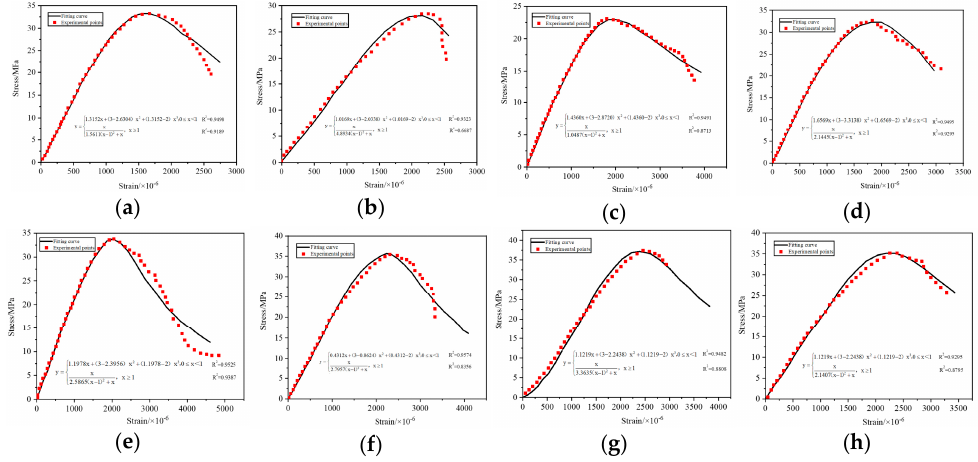
Figure 9. Stress–strain curve models of different kinds of coarse aggregate concrete: ( a ) NCAC; ( b ) UCGC; ( c ) SCGC; ( d ) MSWC; ( e ) GSWC; ( f ) IWRC; ( g ) SCCC; ( h ) RCAC.